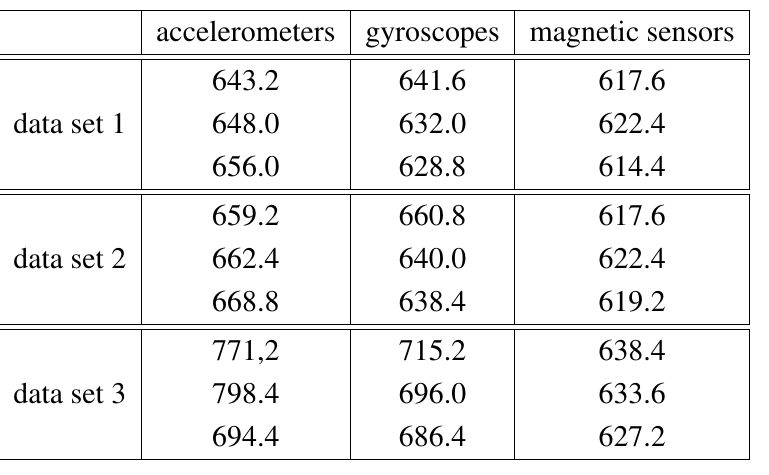
Table 2. Bit rates for 3 inertial and magnetic sensor data